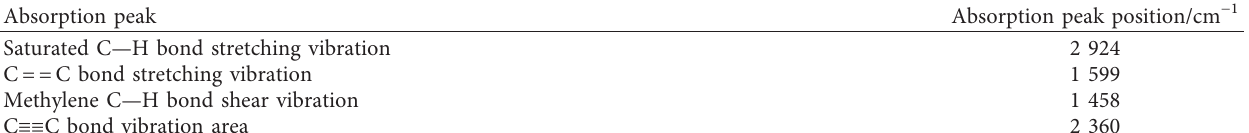
Figure 4: SEM photos of ordinary and modified crumb rubber: (a) ordinary crumb rubber (1500x); (b) modified crumb rubber Table 7: The asphalt rubber’s position and home form in the infrared spectrum.